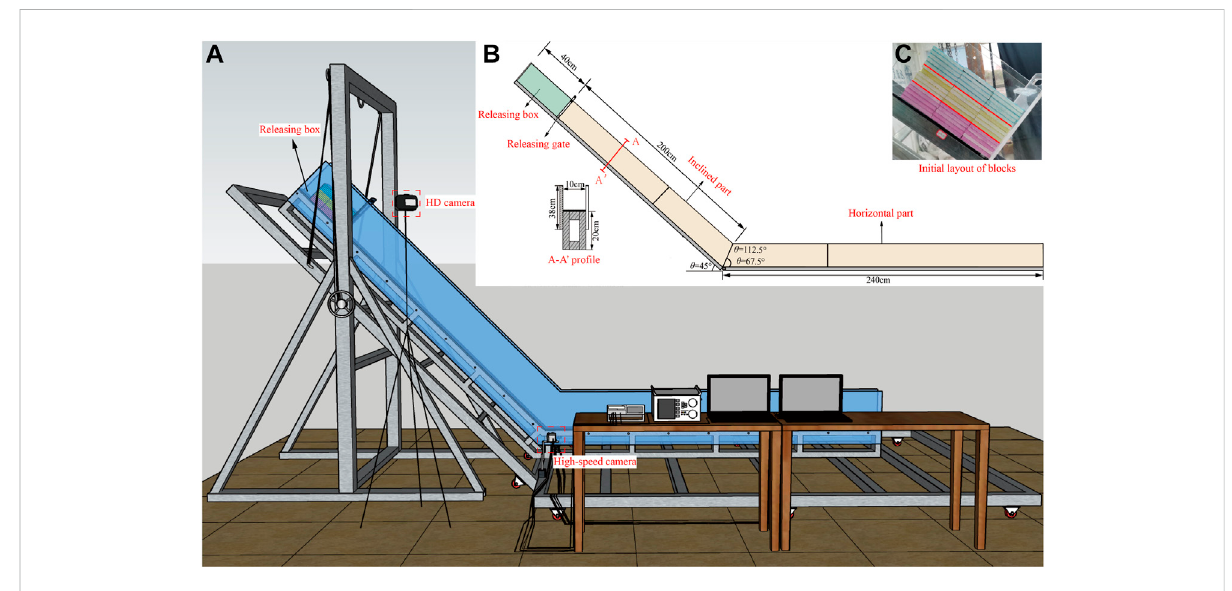
FIGURE 3 Schema of the experimental setup (A,B) and initial layout of blocks (C) .